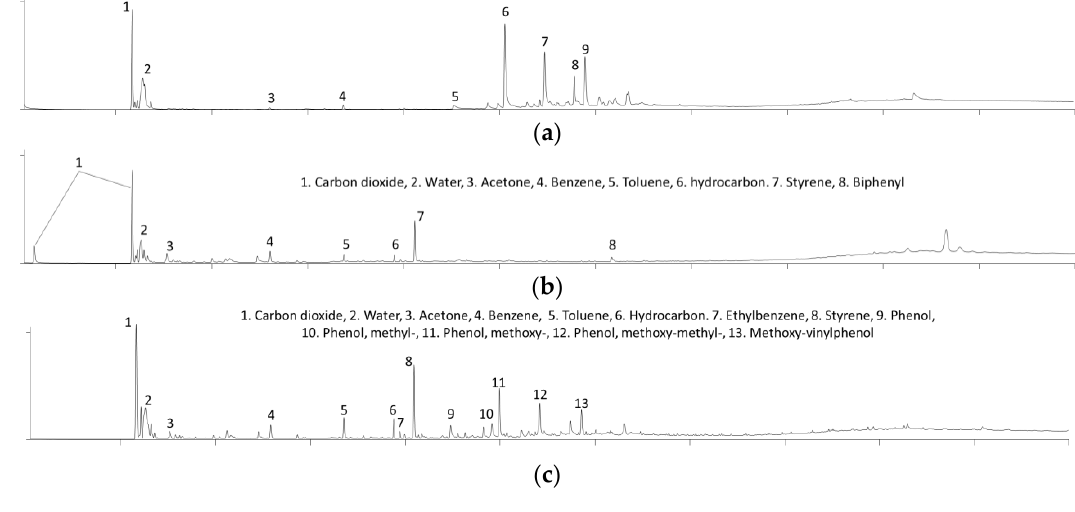
Figure 3. Pyrogram of non CP ( a ) KL, ( b ) RDF, ( c ) RDF+KL.